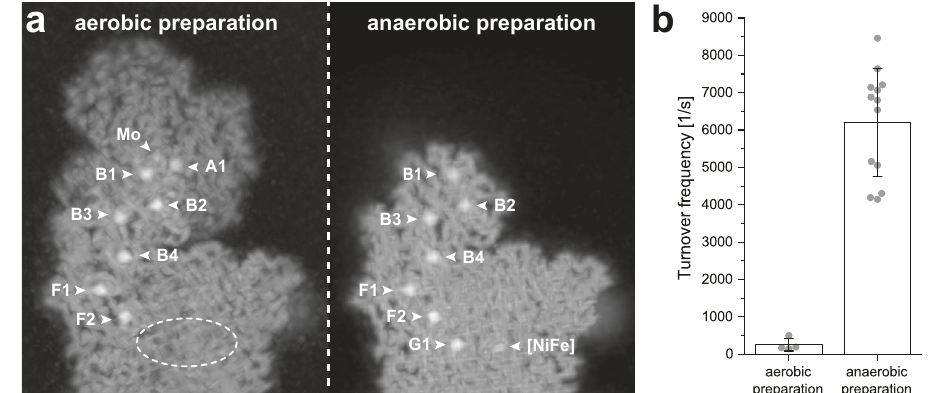
Fig.2|ComparisonofaerobicallyandanaerobicallypreparedFHL.a Solid-view representation of unsharpened maps of aerobically prepared FHL shows strong intensity for the [4Fe4S] clusters in FdhF (A1), HycB (B1-B4) and HycF (F1, F2). Densityfortheproximal[4Fe4S]clusterG1inHycGandthe[NiFe]cofactorinHycE is weak (the approximate position is indicated with a dashed ellipse). The anae- robically prepared FHL shows strong density for the proximal [4Fe4S] cluster (G1)